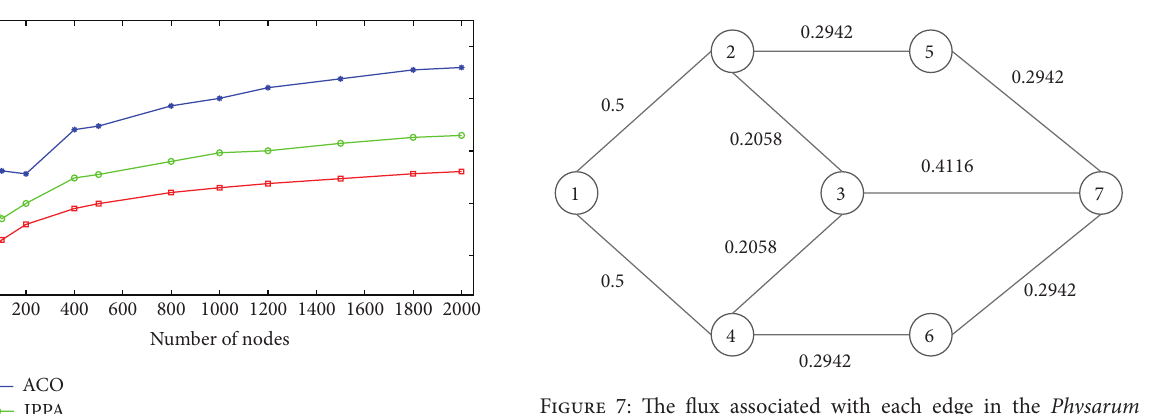
Figure 7: The flux associated with each edge in the Physarum polycephalum algorithm. Table 1: The related parameters of the erdos.renyi.game function.